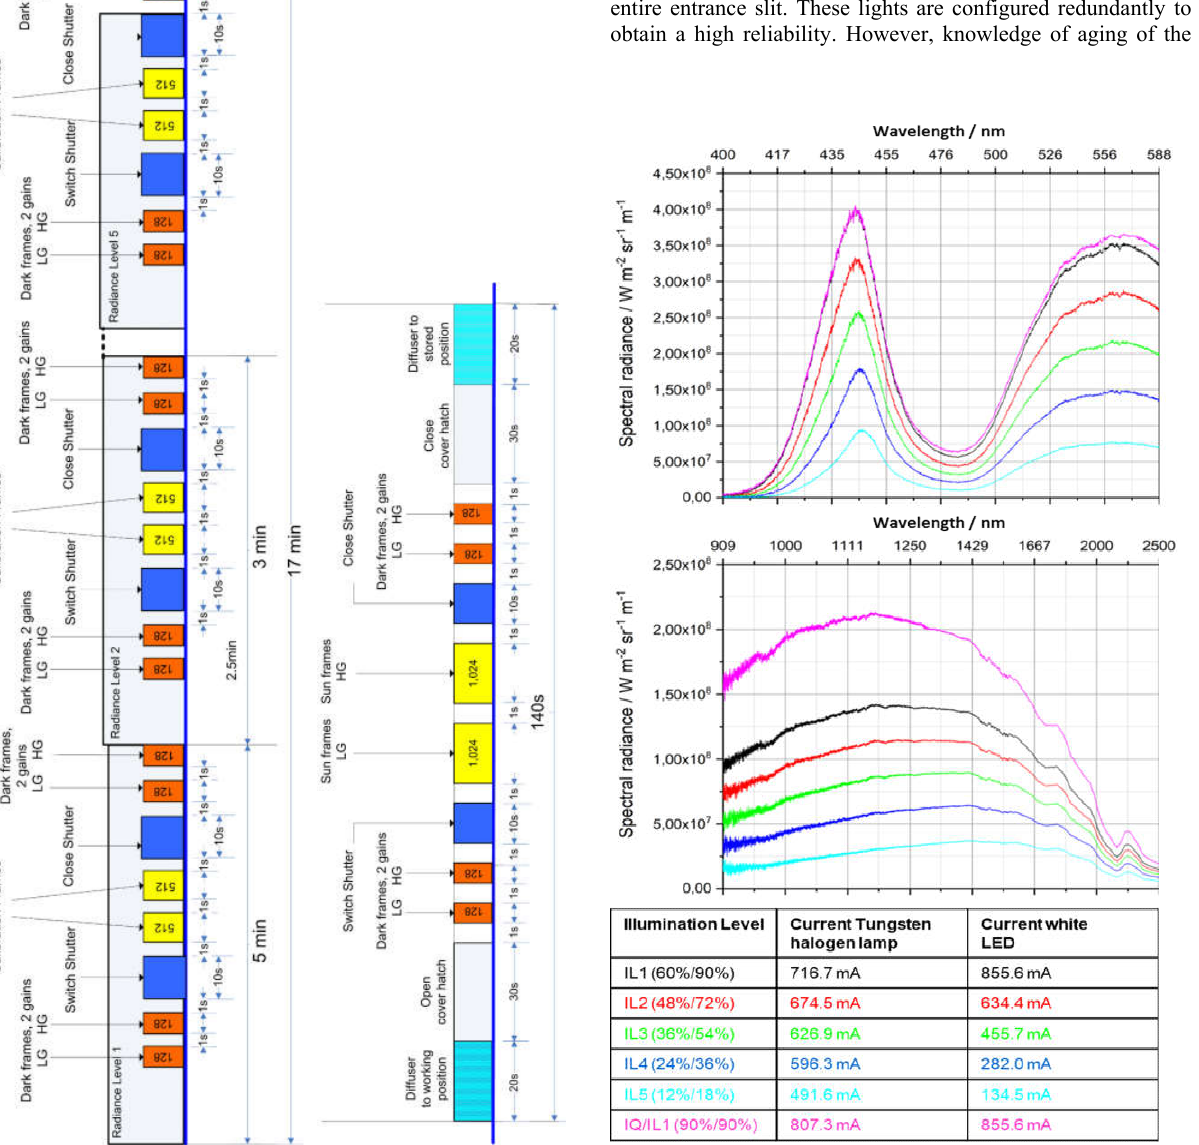
Figure 2. Sequence for relative (left) and absolute (right) radiometric calibration. (Images by OHB System AG.)